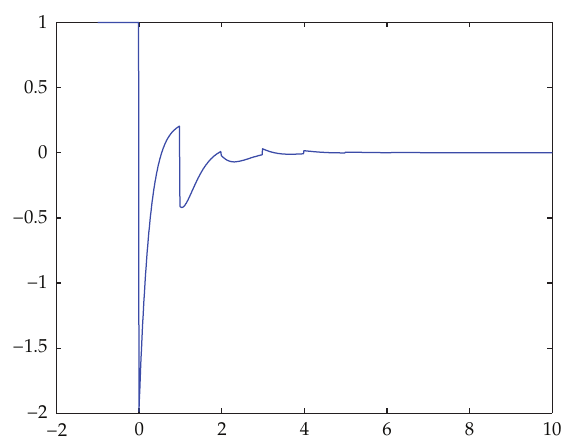
Figure 2: The numerical solution of (cid:3) 4.1 (cid:4) , when (cid:3) 3.1 (cid:4) is the Trapezoid method as h (cid:7) 1 / 100.